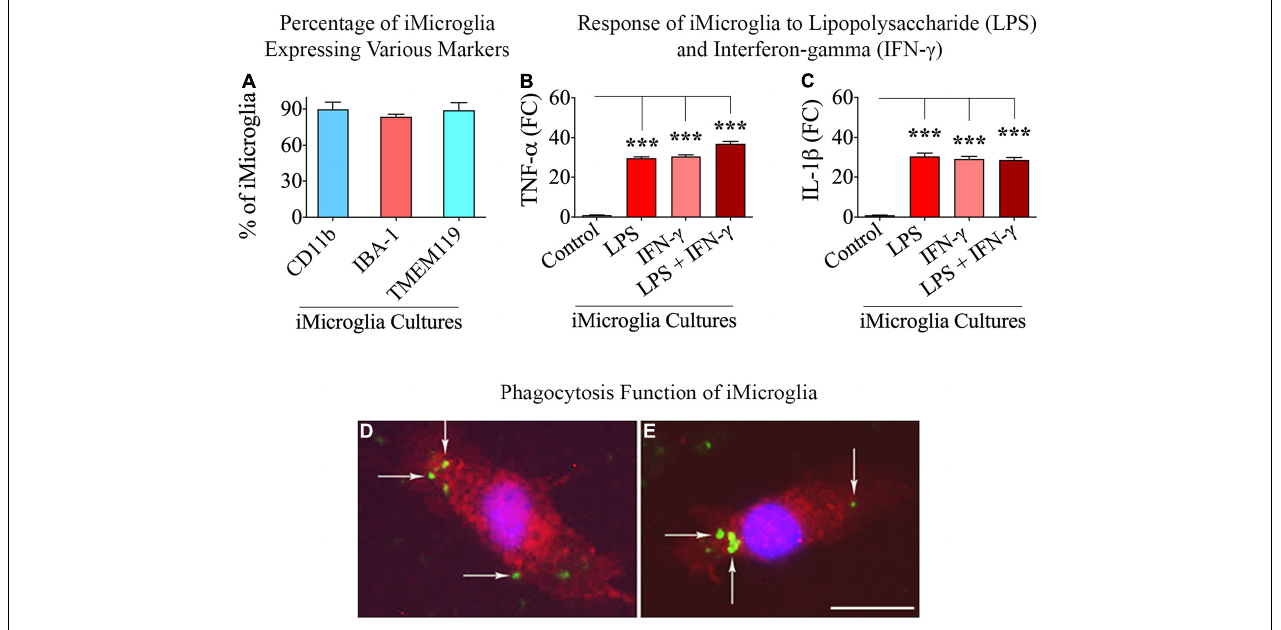
FIGURE 3 | Percentages of total cells expressing microglia-specific markers in iMicroglia cultures, the response of iMicroglia to proinflammatory stimuli, and phagocytosing property of iMicroglia. Bar chart (A) shows percentages of total cells expressing CD11b, IBA-1, and TMEM119 in iMicroglia cultures. The bar charts in (B,C) show iMicroglia cultures activated through lipopolysaccharide (LPS), interferon-gamma (IFN- γ ), or LPS + IFN- γ , secreting elevated levels of proinflammatory cytokines tumor necrosis factor-alpha (TNF- α ) and interleukin-1 beta (IL-1 β ). (D,E) Illustrate mature IBA-1 + iMicroglia (red) following the internalization of fluorescently labeled A β (green), confirming their proficiency for phagocytosis. *** p < 0.001, (D,E) 25 µ